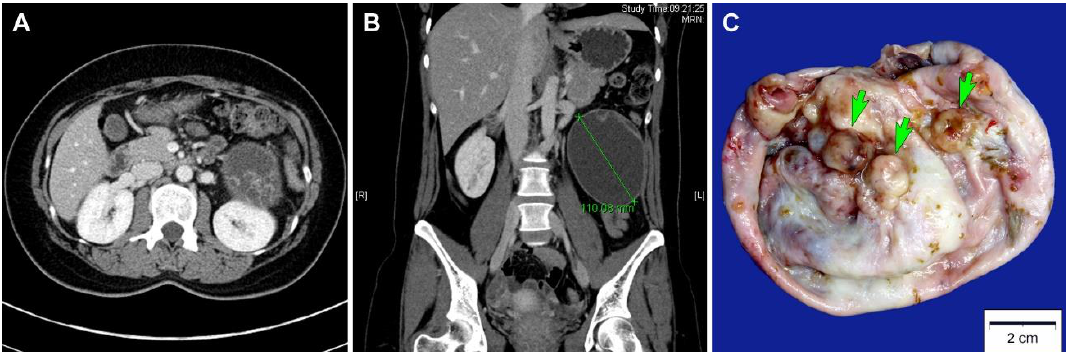
Figure 1. Imaging and gross findings. ( A ) Abdominopelvic computed tomography scan in axial view, which revealed a thick-walled cystic mass in the left retroperitoneal space. The mass had some daughter cysts. ( B ) Abdominopelvic computed tomography scan in coronal view, which revealed a well-circumscribed, ovoid unilocular cystic mass with a diameter of 11 cm. ( C ) Grossly, the inner surface of the mass showed some round-to-ovoid, variegated mural nodules (green arrows), measuring up to 1.2 cm in the greatest dimension.